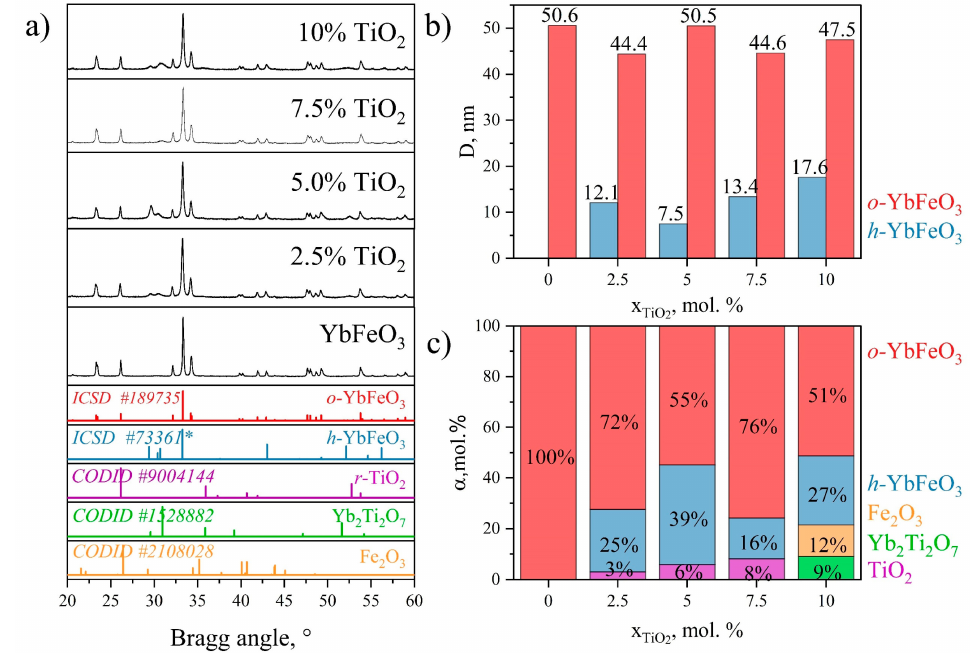
Figure 3. PXRD patterns of o -YbFeO 3 / h -YbFeO 3 / r -TiO 2 ( a ), average crystallite sizes (D, nm) ( b ) and molar fraction ( α , mol.%) ( c ) versus TiO 2 content (mol.%).